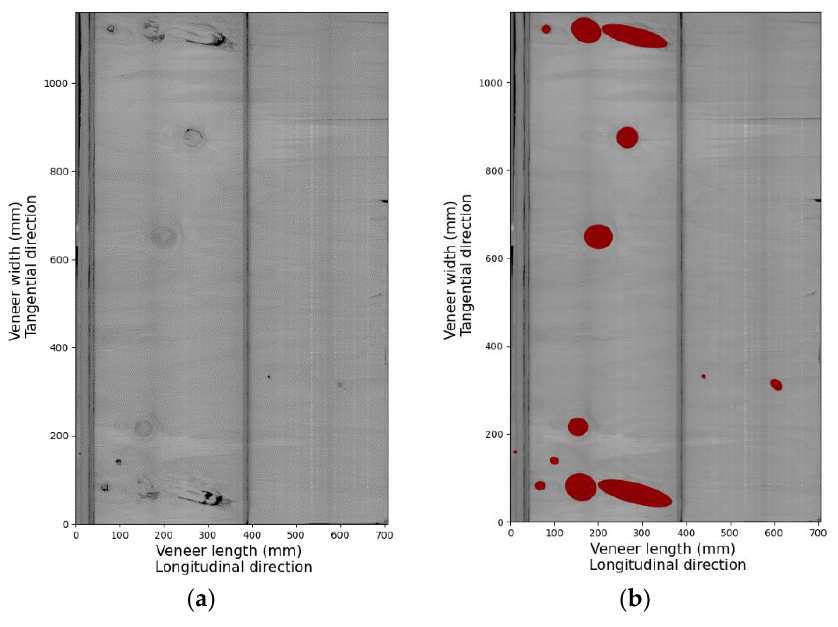
Figure 4. Veneer: ( a ) grayscale image, ( b ) manual knot